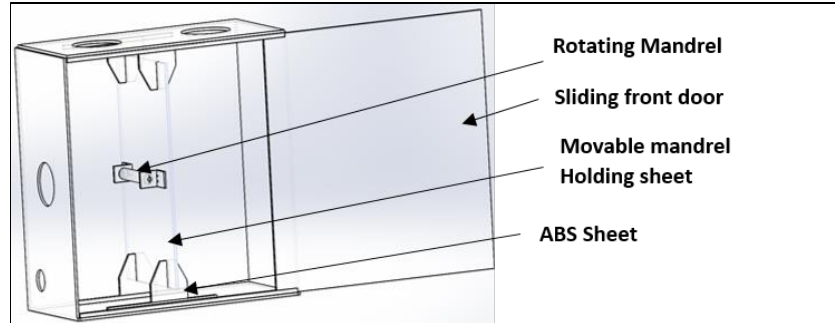
Figure 19. Enclosure, mandrel in the 3D model [ 171 ] .